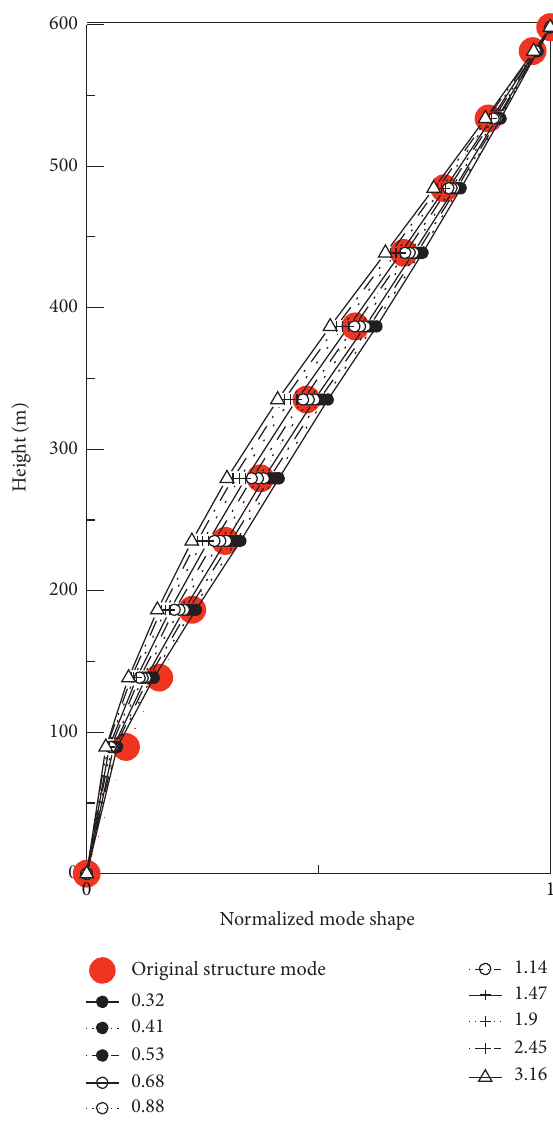
Figure 14: Sensitivity of the first-order mode shape to the flange wall stiffness of the simplified